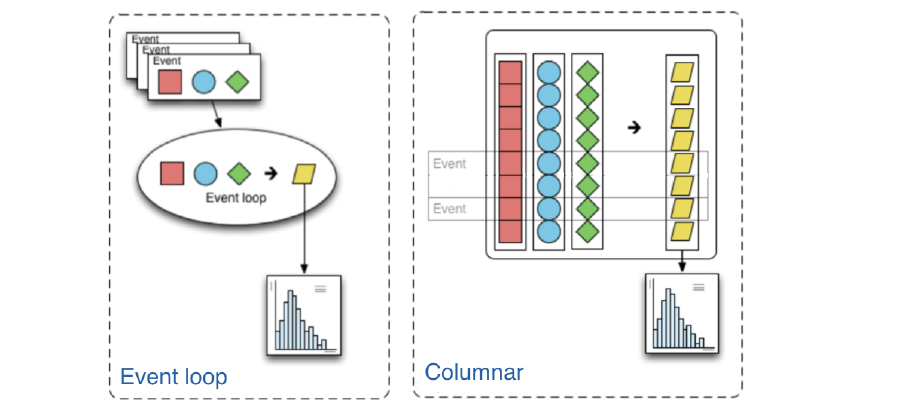
Figure 1. Schematic of the event-loop (left) and columnar (right) data processing